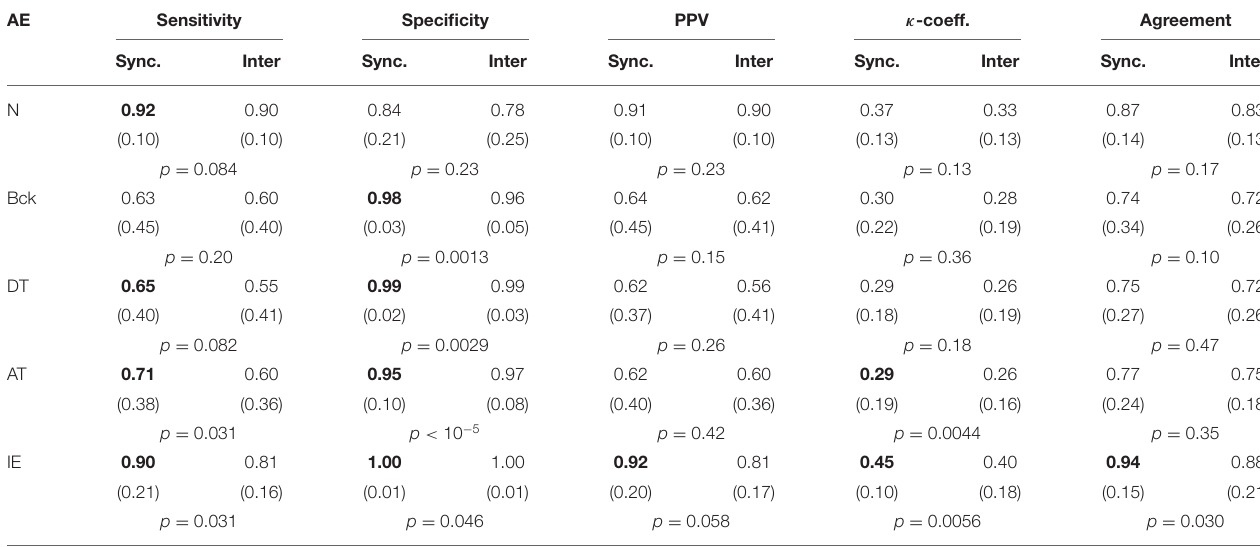
TABLE 3 | Sensitivity (Se), specificity (Sp), positive predictive value (PPV), κ -coefficient, and agreement for the automatic scoring by SyncSmart successively compared to each expert and for each expert successively compared to one another. AE Sensitivity Specificity PPV κ -coeff.